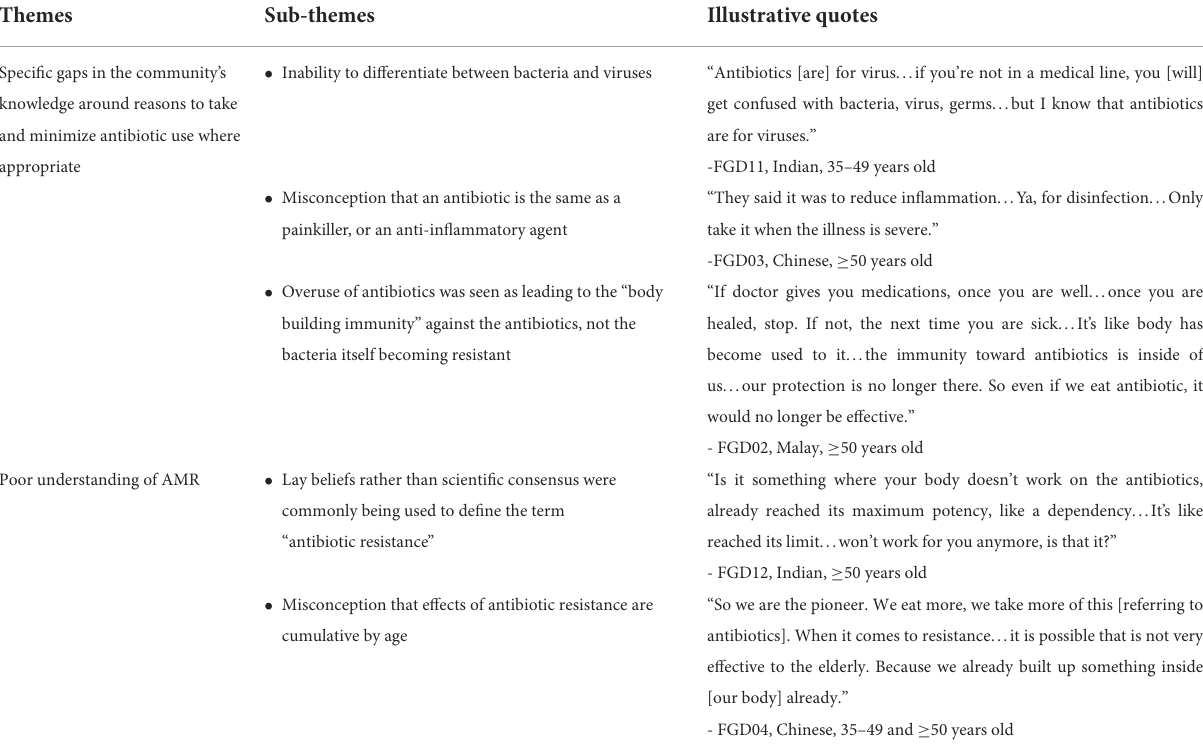
TABLE 1A Gaps in knowledge, themes collated from focus group discussion data.